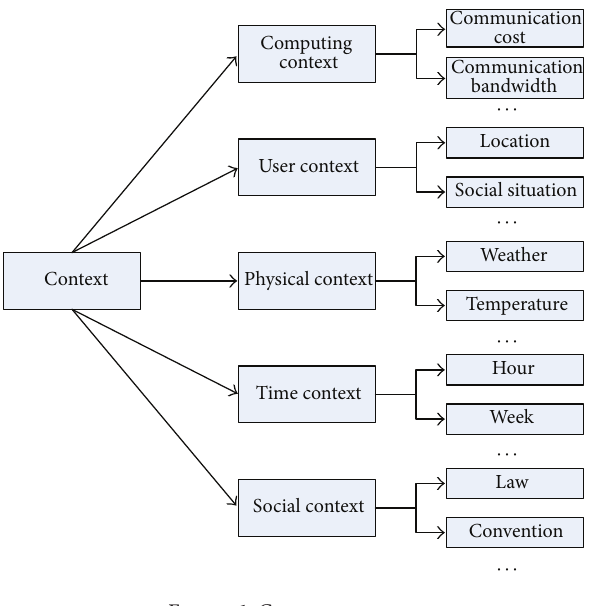
Figure 1: Context